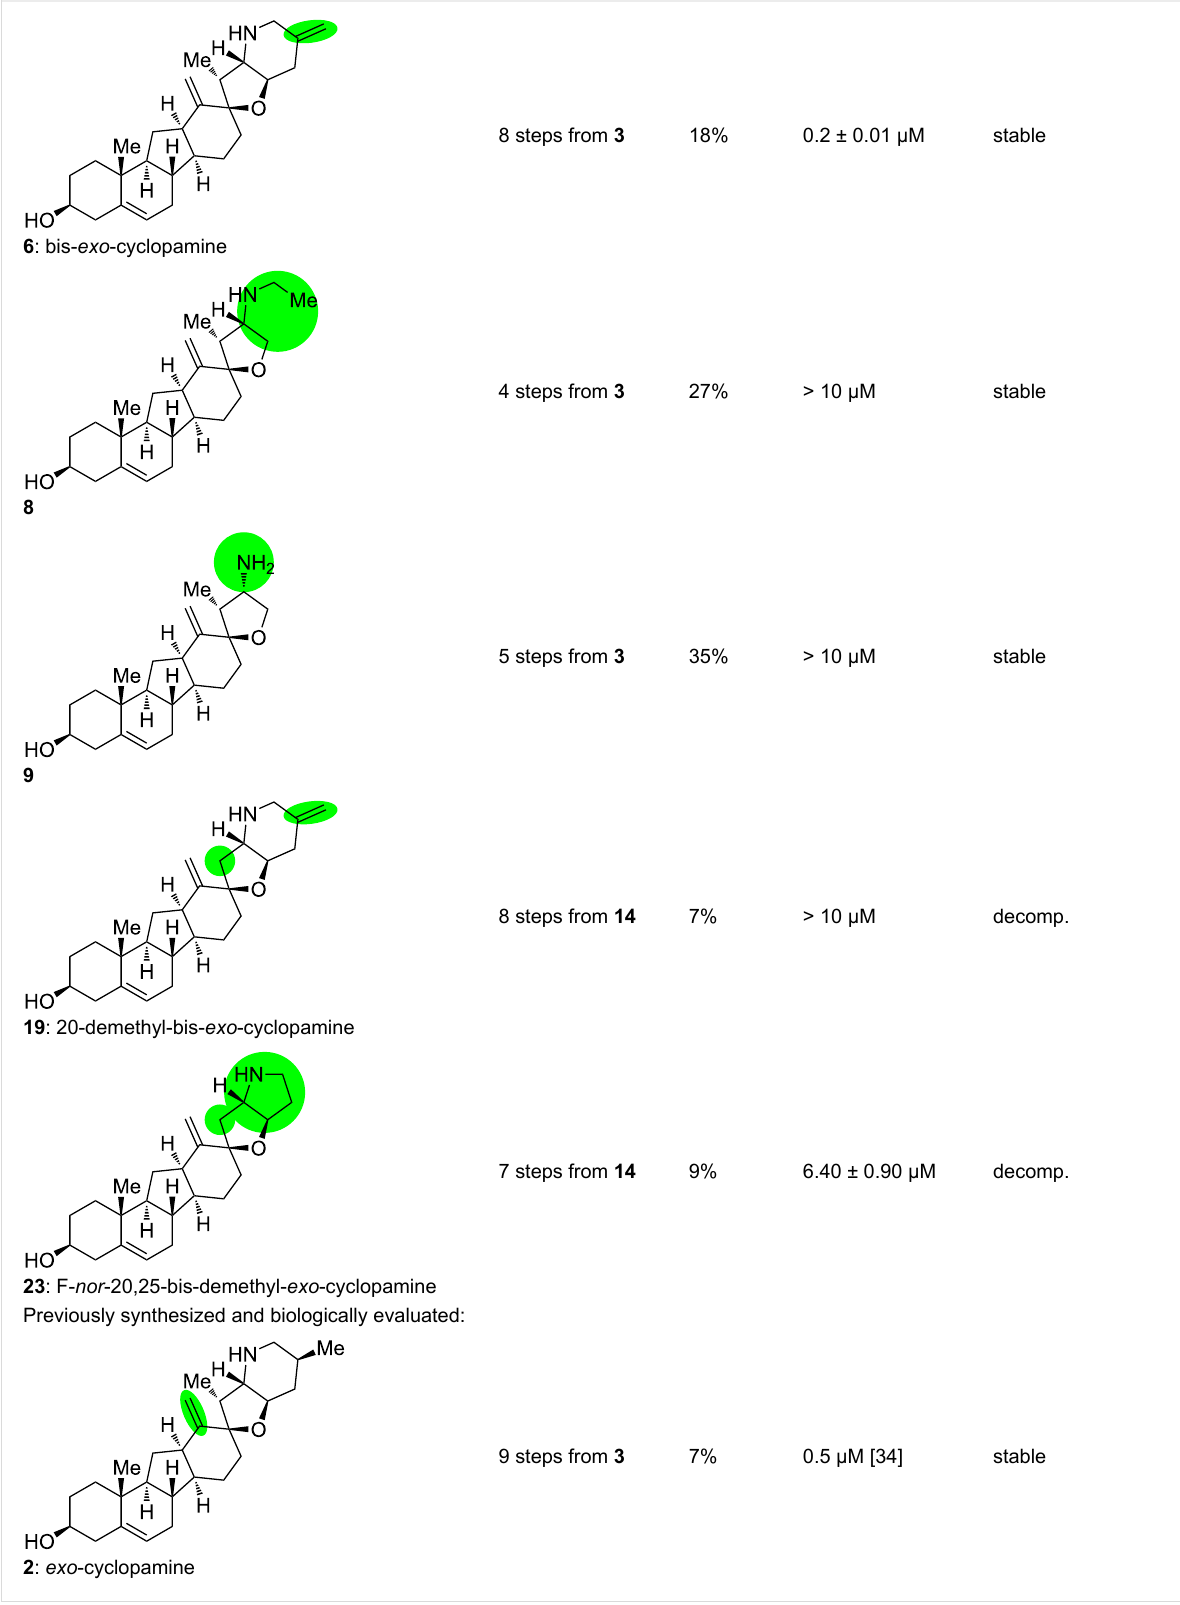
Table 1: Synthesized exo -cyclopamine derivatives, number of steps, yields, results of their biological testing, and stability towards acid.